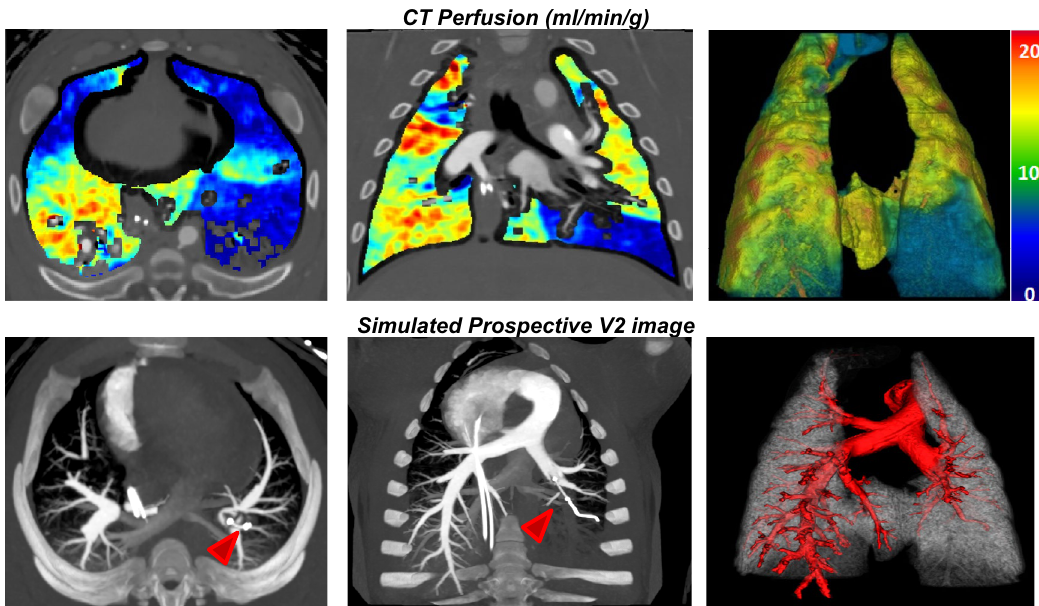
Figure 6. Representative CT perfusion maps and the prospectively predicted V2 image. Top row: Axial, coronal, and 3D posterior views in the presence of balloon occlusions are shown. The color bar on the right indicates the perfusion in the range from 0 to 20 ml/min/g. Bottom row: Axial, oblique-coronal CT angiography using maximum intensity projection reconstruction with 20 mm thickness and 3D pulmonary arteries extraction (Using V2). Red arrows point at the angioplasty